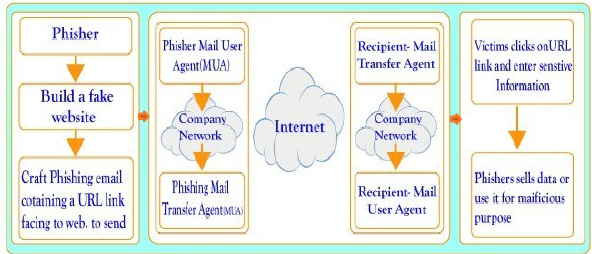
Figure 1 . State-of-the-art of URL based E-mail